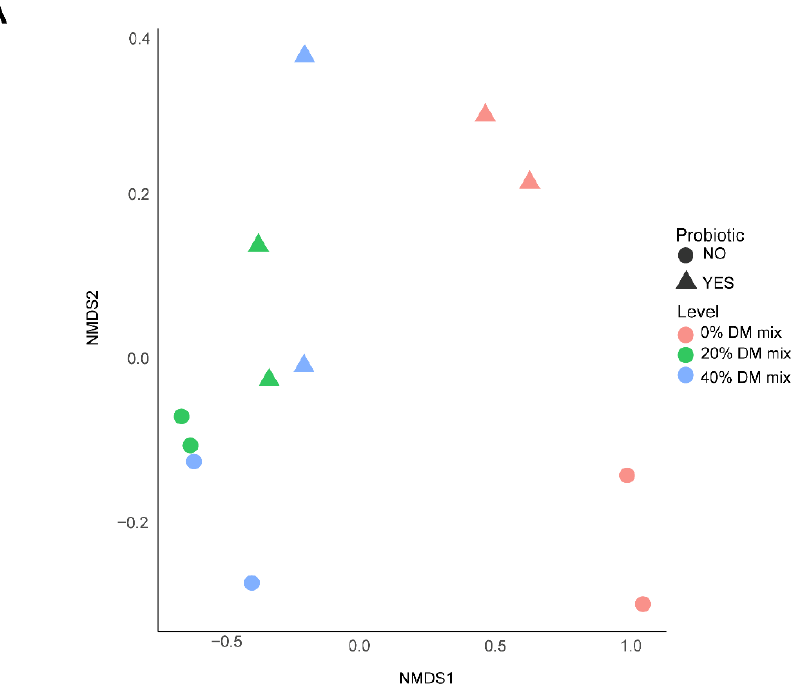
Figure 1. Non–metric multidimensional scaling (NMDS) plot based on the Bray–Curtis dissimilari- ties of the bacterial and archaeal microbiota of sorghum mixed with 0, 20 or 40% DM vegetable mix after ( A ) 101 d ensiling and ( B ) after 14 d aerobic exposure, with or without a probiotic inoculant. Among the 59 archaeal and bacterial genera identified, Weissella had the highest rel- ative abundance in uninoculated samples with 20% DM mix inclusion (52.7 ± 2.22%; p < 0.01; Table S4), while similarly dominating 0% mix samples with or without probiotic in- oculant (36.9 vs. 39.9 ± 2.22%; p < 0.01). Pediococcus and Lactiplantibacillus dominated ( p < 0.01) the bacterial and archaeal communities of 0% DM mix samples at 39.4 ± 0.84%, and 16.5 ± 0.82% compared to 20 or 40% DM mix, irrespective of probiotic, or the interaction of level x probiotic. However, Lentilactobacillus and Lactobacillus (41.8 ± 3.99% and 30.0 ± 2.67%; p < 0.01) were the most dominant taxa among inoculated 40% DM mix samples, while Lactobacillus dominated (71.7 ± 2.67%; p < 0.01) the uninoculated 40% DM mix silage microbiota. Tendencies (Table S4) were noted for Serratia , Stenotrophomonas, and Chryseo- bacterium , which decreased in relative abundance with inoculation, while Serratia was also reduced ( p = 0.07) with increasing vegetable mix inclusion.